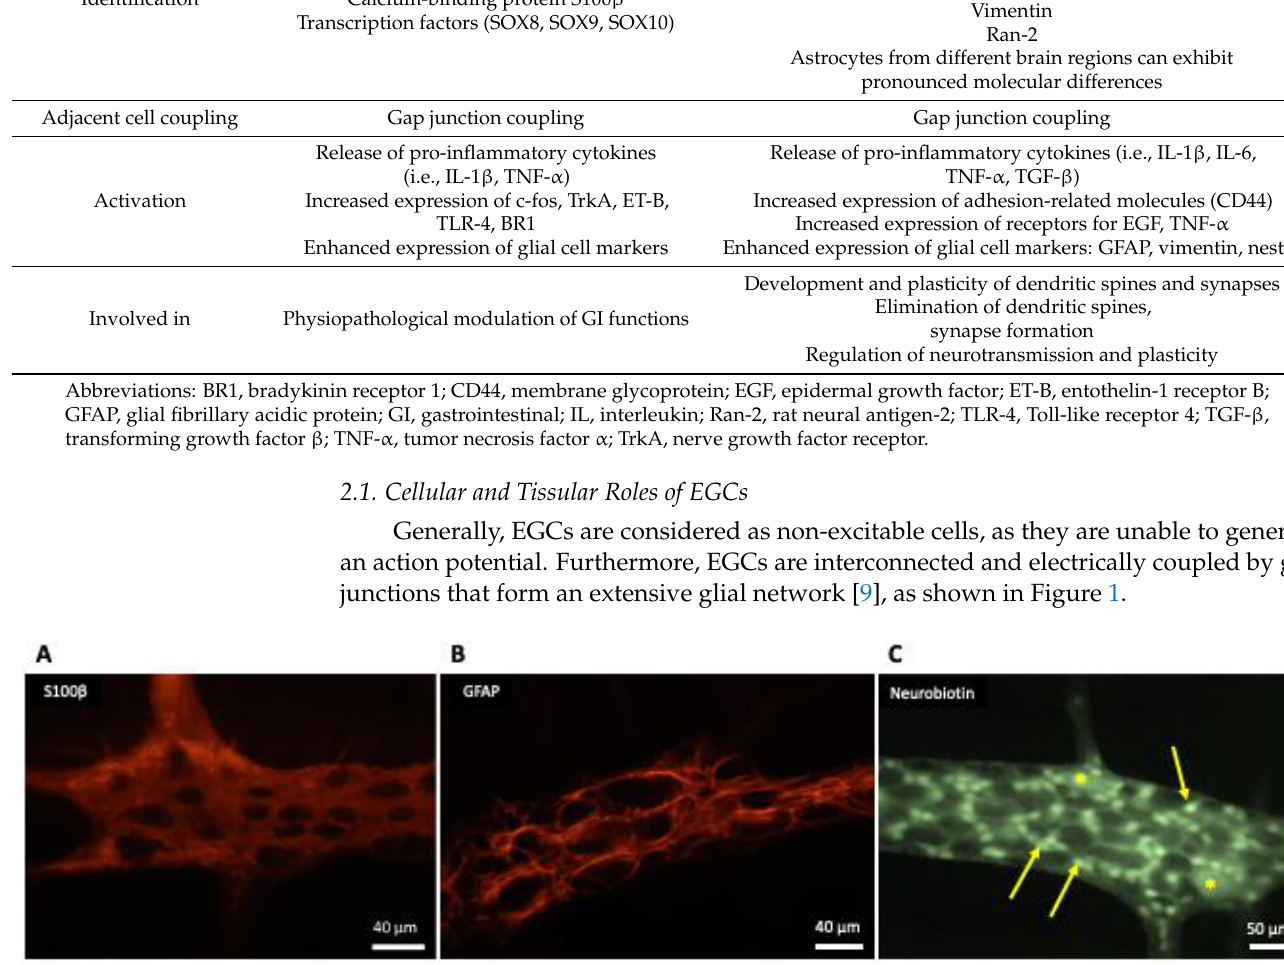
Figure 1. Appearance of enteric glial cells (EGCs). ( A , B ) Show the images obtained from the myenteric plexus of the rat distal colon; immunoreactivity to S100- β ( A ) and glial fibrillary acidic protein (GFAP) ( B ) are characteristic for EGCs. ( C ) Shows the network of electrically-coupled EGCs (arrows) in one myenteric ganglion from the guinea pig ileum; this image was taken as the result of the accidental insertion of an electrode filled with neurobiotin in one EGC while performing electrophysiological recordings of the activity of myenteric neurons (*); neurobiotin injected into one EGC diffused throughout the gap junctions connecting it with the other EGC in the myenteric ganglion, in the same way as firstly described by Hanani et al. [9] in 1989 for Lucifer yellow